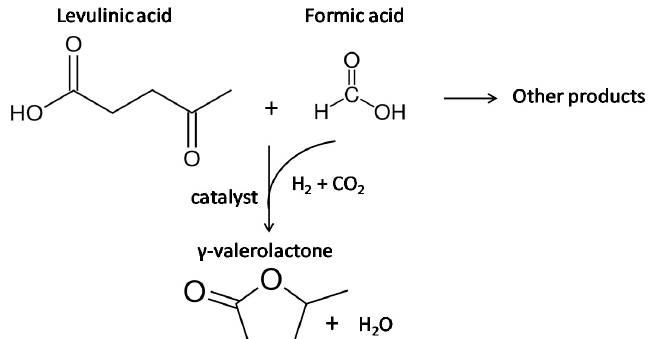
Table 1. Overview of Ni catalysts for GVL synthesis from methyl levulinate (ML), ethyl levulinate (EL) and levulinic acid